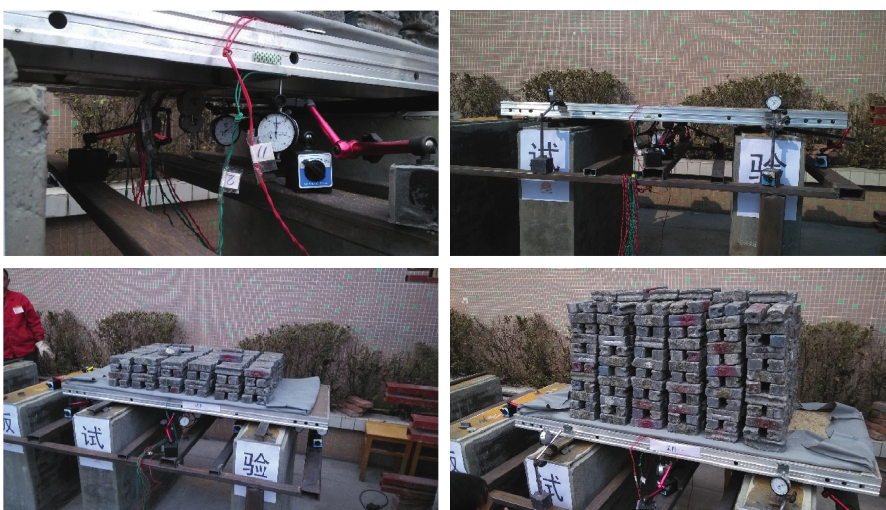
Figure 6: Loading process of the single-span simply supported formwork.